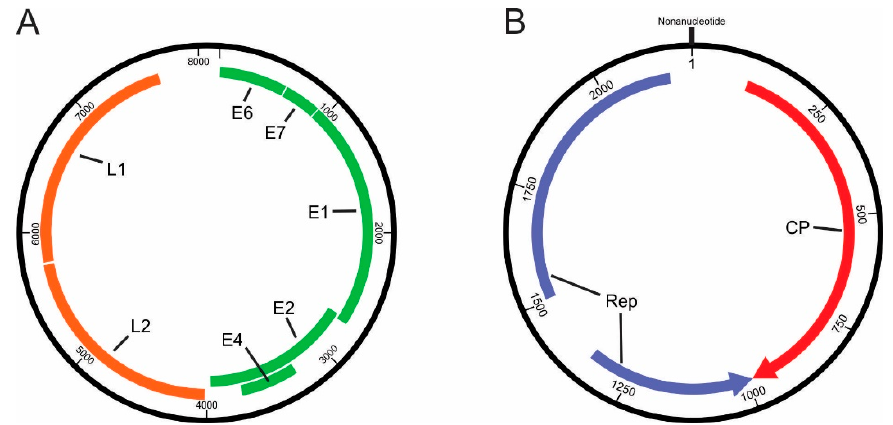
Figure 2. ( A ) Tadarida brasiliensis papillomavirus type 1 (TbraPV1) genome diagram indicating the positions of annotated PV genes. All genes are read from the direct strand. Genes encoding early and late proteins are depicted with green and orange lines, respectively. ( B ) Tadarida brasiliensis gemykibivirus 1 (TbGkyV1) genome diagram. Genes encoding the replication initiation protein (Rep) and the capsid protein (CP) are shown with blue and red arrows, respectively. Note that the Rep gene is on the reverse-complemented strand. The position of the nonanucleotide (TATAAATAG) is also indicated.